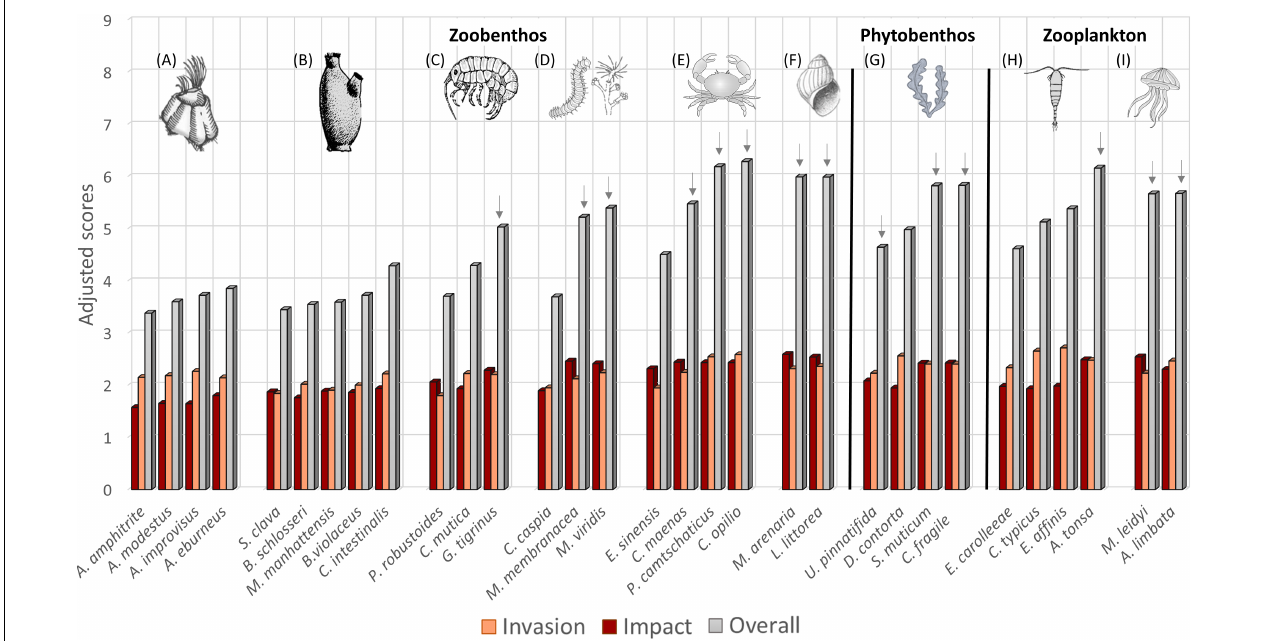
FIGURE 3 | Adjusted Invasion, Impact, and CMIST overall risk scores for ecological categories and taxonomic groups assessed for the Hudson Bay Complex marine ecoregion, including Zoobenthos: (A) barnacles, (B) tunicates, (C) amphipods, (D) other zoobenthos, (E) crabs, (F) mollusks; Phytobenthos: (G) macroalgae; and Zooplankton: (H) copepods, (I) macrozooplankton. Arrows identify HHR (scores ≥ 2.0 in Invasion and Impact).